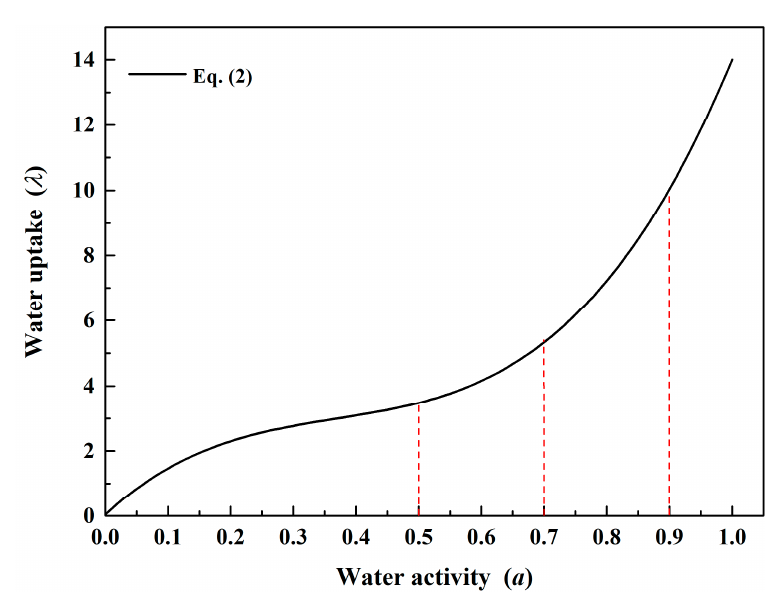
Figure 5. Relation between water uptake and membrane water activity.